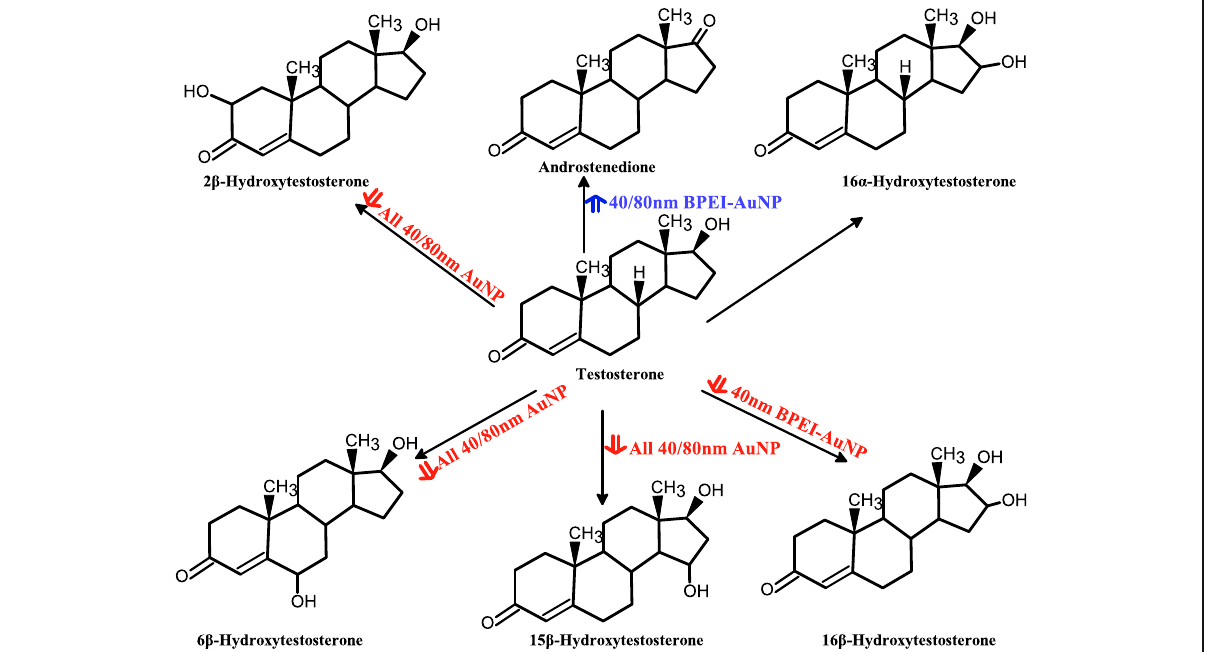
Fig. 7 Proposed scheme of testosterone metabolism in pooled human liver microsomes and AuNP-mediated its metabolites production. AuNP gold nanoparticles, BPEI branched polyethylenimine, LA lipoic acid, PEG polyethylene glycol, PC human plasma protein corona. Red arrow, inhibitory effect; blue arrow, stimulatory